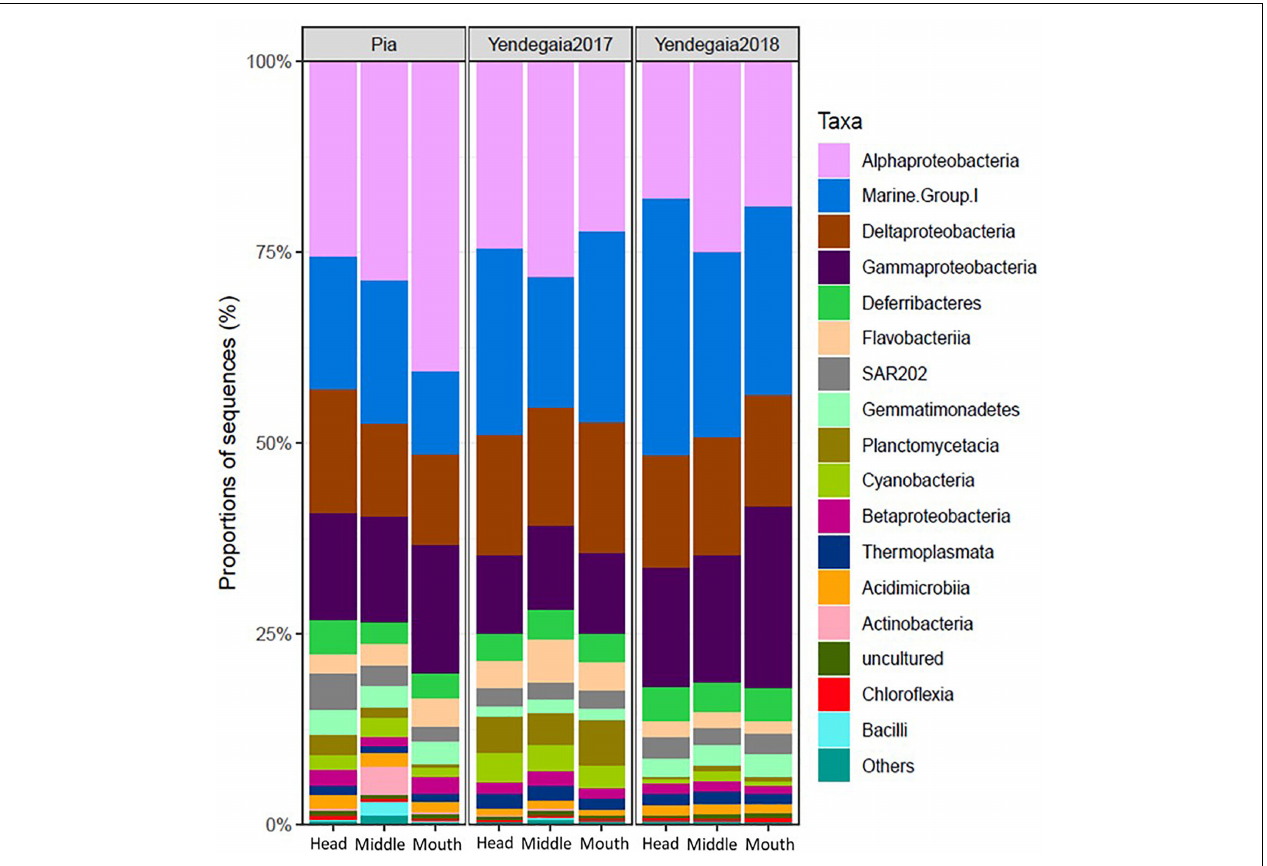
FIGURE 5 | Composition of the microbial communities at the Class level in the RNA fraction in Pia fjord and Yendegaia fjord in 2017 and 2018.